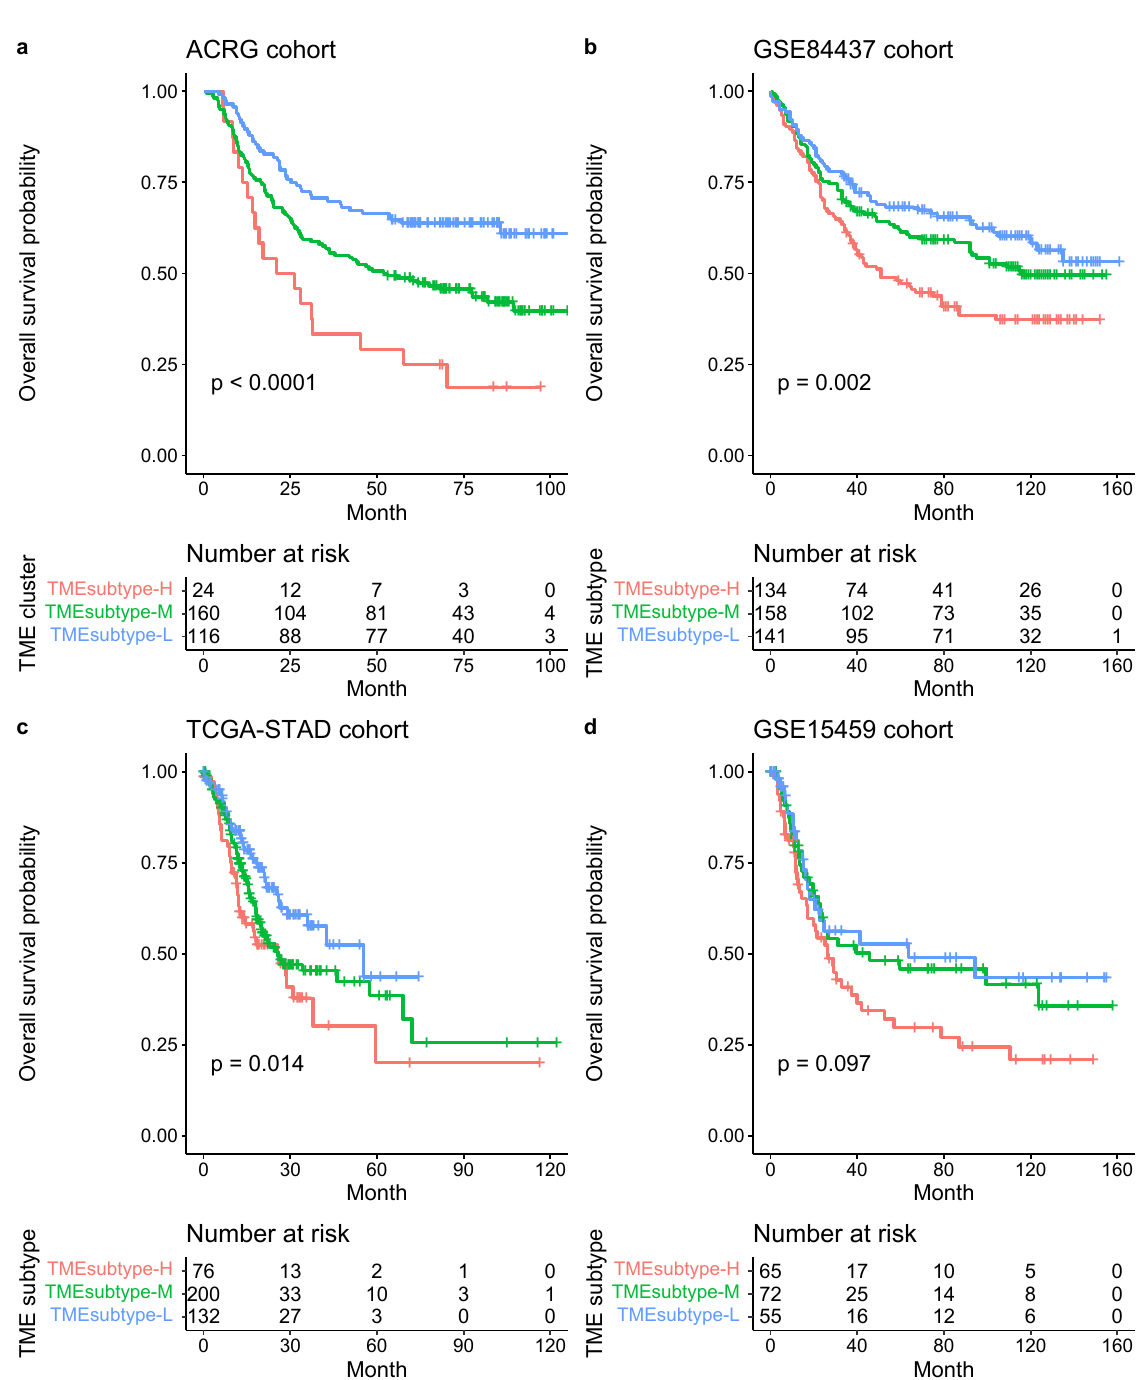
Figure 17. Kaplan–Meier plots for the OS of patients stratified into three TME subtypes in the ACRG ( a ), GSE84437 ( b ), TCGA-STAD ( c ), and GSE15459 ( d ) cohorts. Significance test p value is shown in the lower